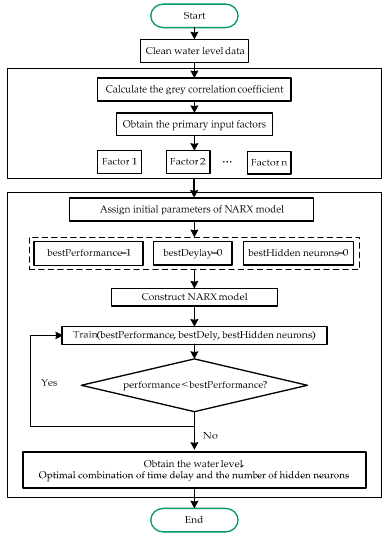
Figure 4. The flowchart of the GRA-NARX model.